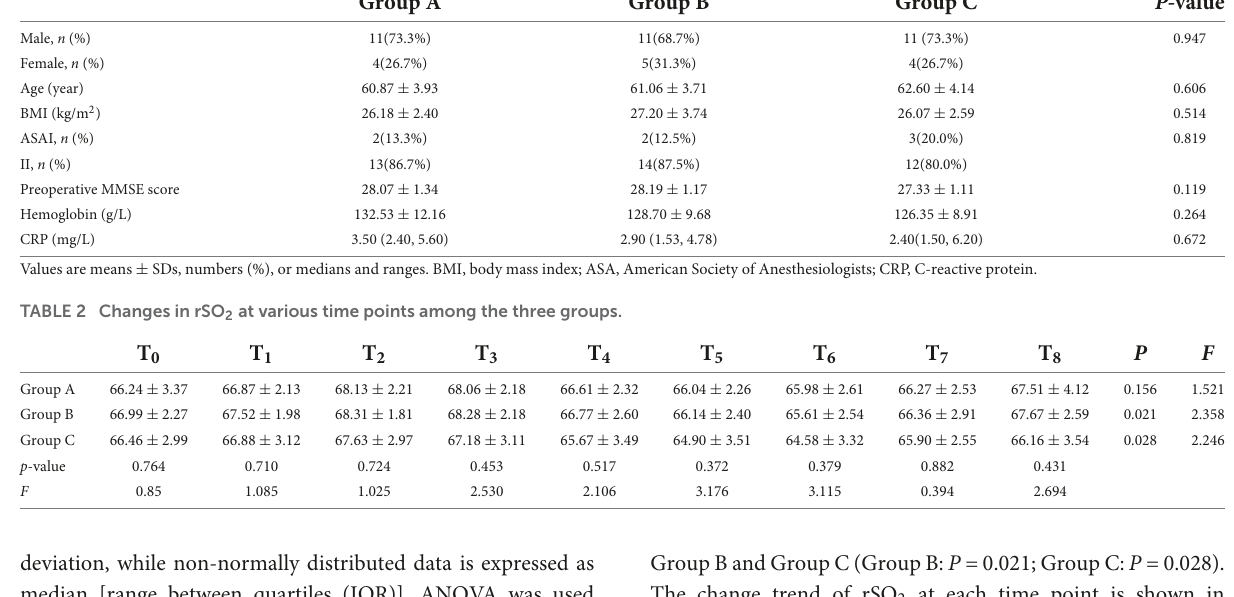
Group B and Group C (Group B: P = 0.021; Group C: P = 0.028). The change trend of rSO 2 at each time point is shown in Figure 1 . Before T3, the tendency of rSO 2 in all group was upward, then it began to descend after controlled hypotension. The rSO 2 in Group C was lower than that in the other two groups between T2-T8, but there was no statistical difference. There are relatively clear downward trend of rSO 2 in the Group B and Group C, and the influence of blood pressure on rSO 2 was more obvious at T6.